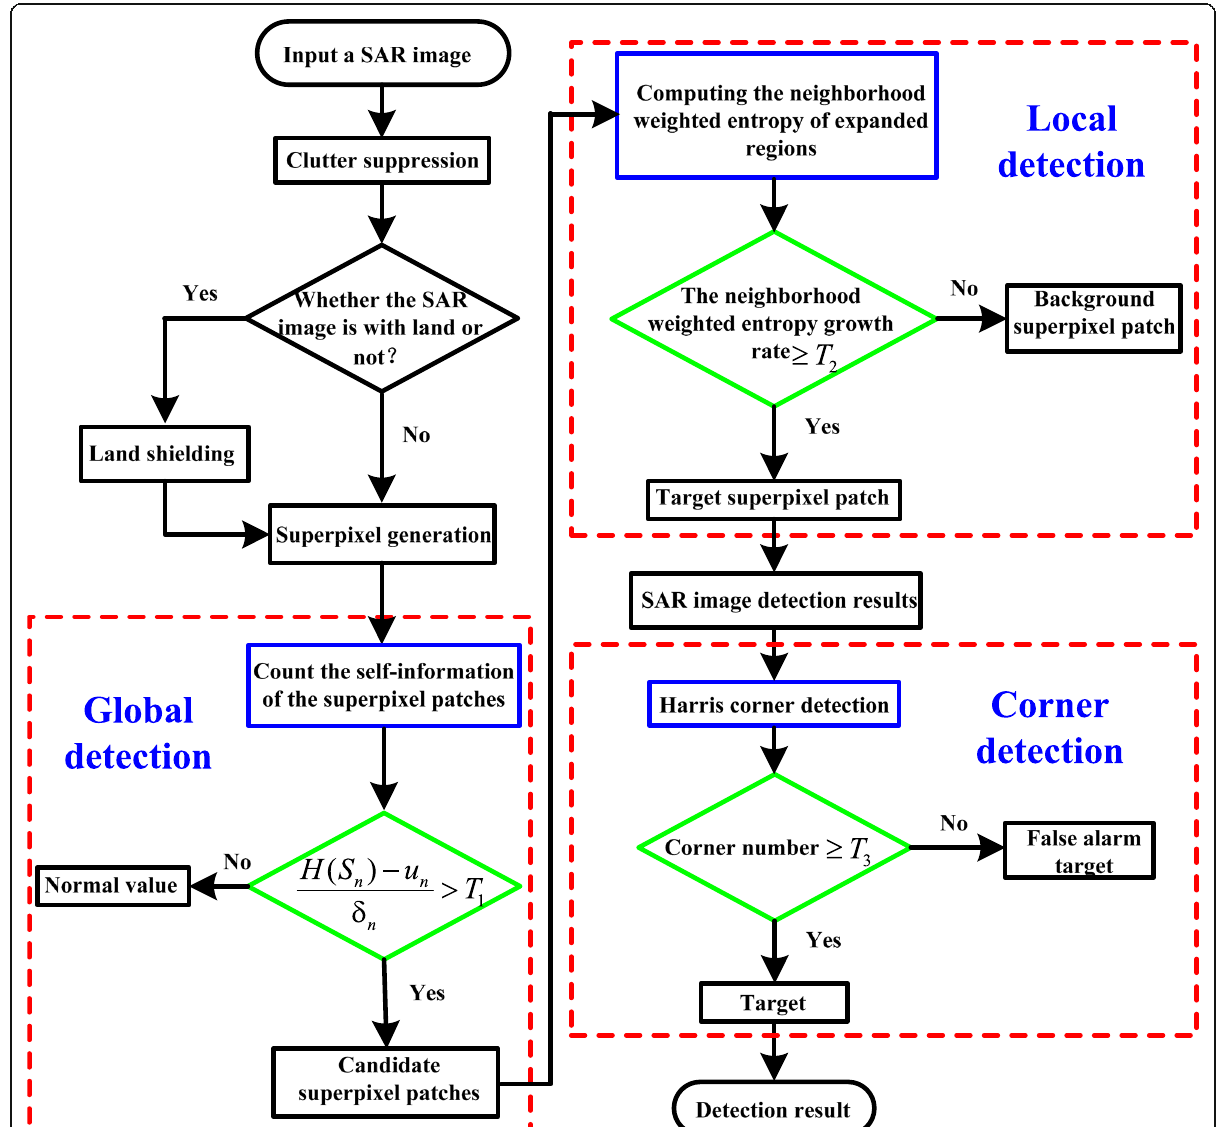
Fig. 1 Flowchart of the proposed ship target detection